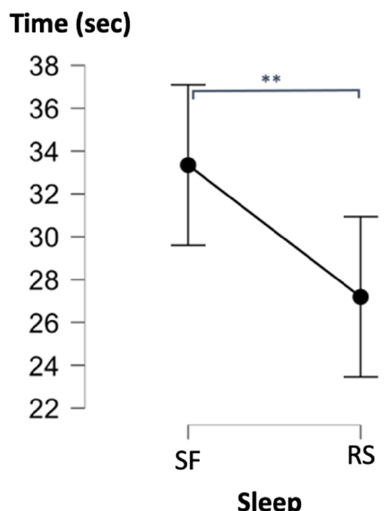
Figure 7. SF-related interference effects (Stroop task). ** p < 0.01. Error bars represent standard errors. Table 2. Outcomes of attentional and memory functions after one night in experimental RS and SF. Control Fragmented Sleep